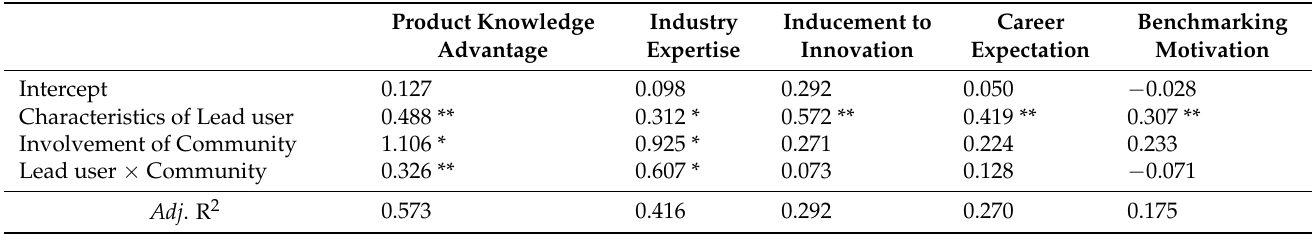
Table 7. Regression analysis from lead users to motivations of user